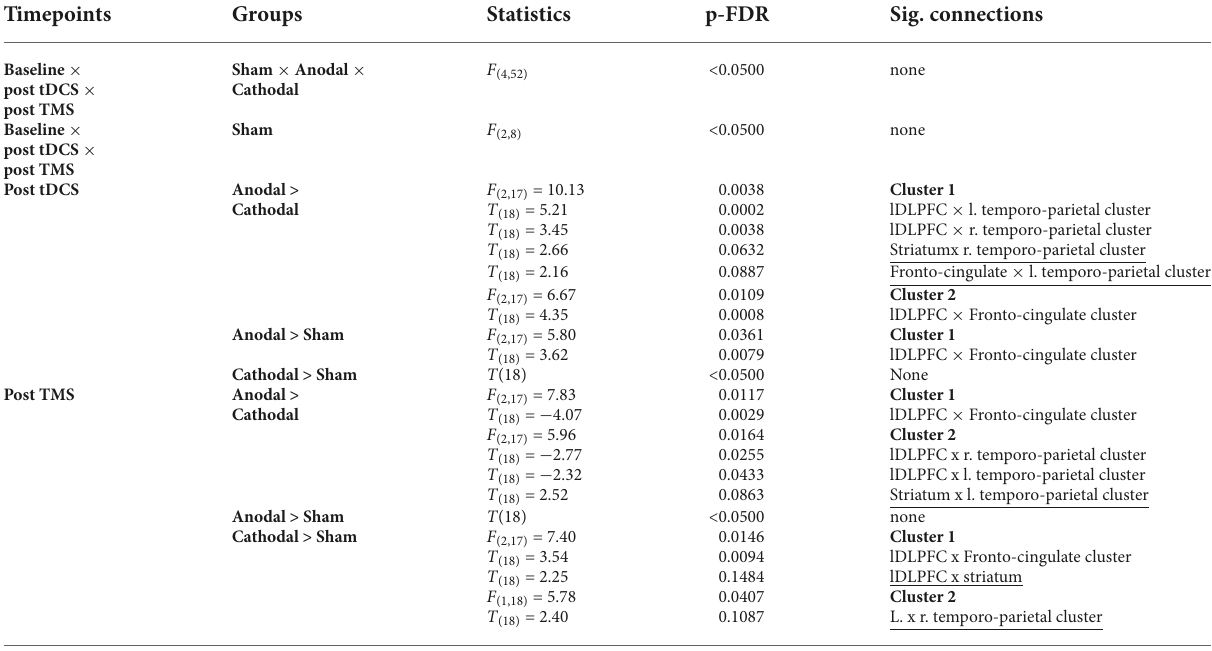
TABLE 3 Results of planned post-hoc T-tests of ROI to ROI